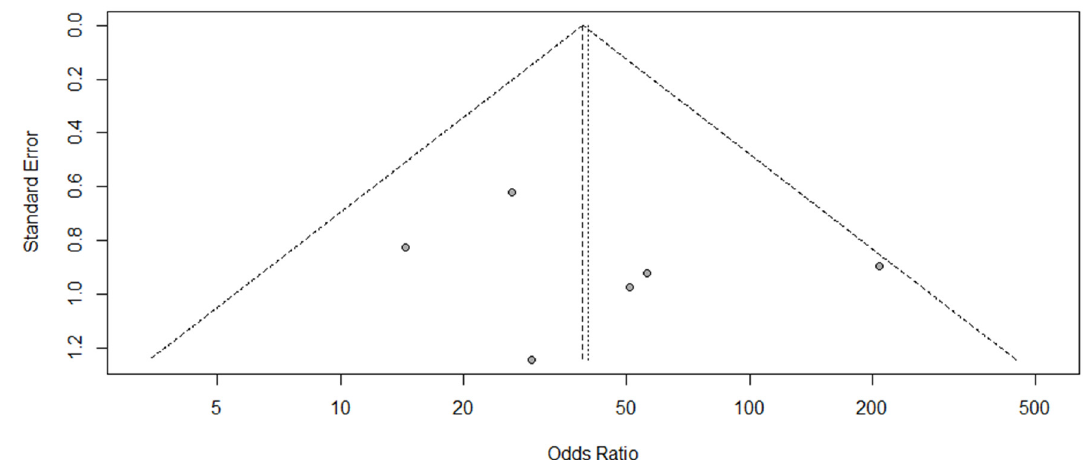
Figure 5. Funnel Figure 5. Funnel plot.